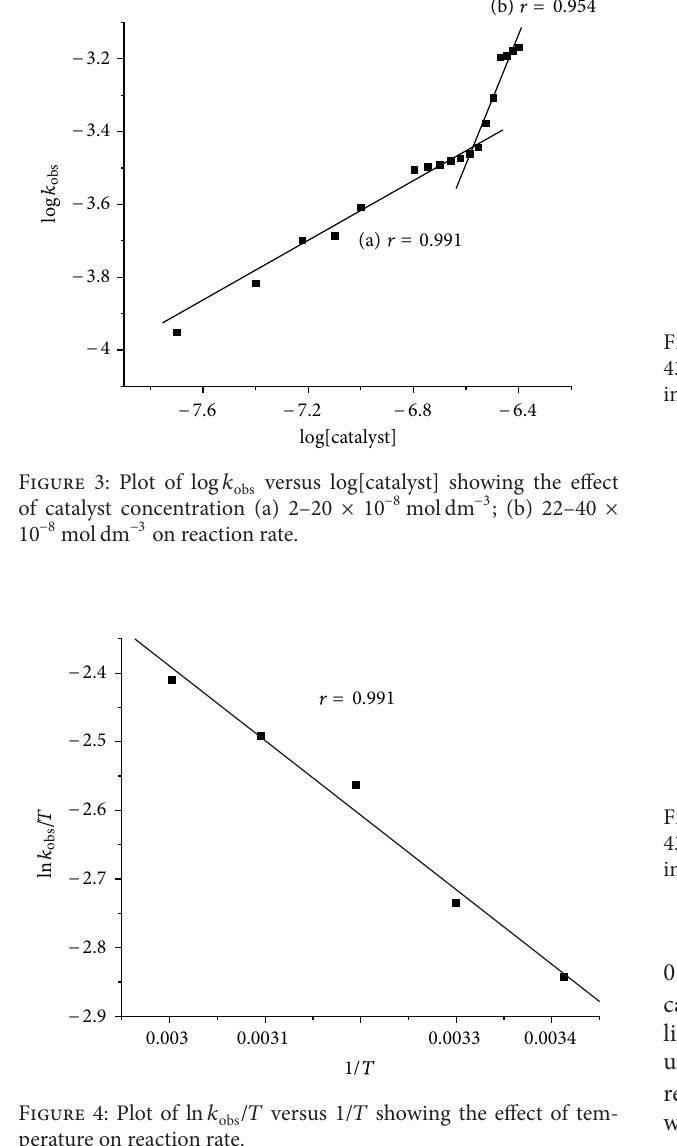
versus 1/ showing the effect of tem- 𝑇𝑇 𝑇𝑇